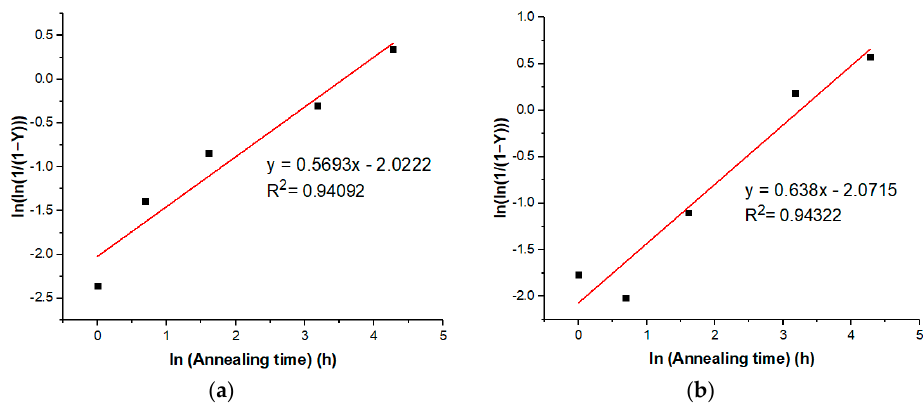
Figure 7. Isothermal phase transformation plots for the VRC-TAR system (T anneal = 60 °C), as described using the Avrami equation based on the ( a ) %RC at 5.10° 2 θ and (b) %RC at 10.21° 2 θ .